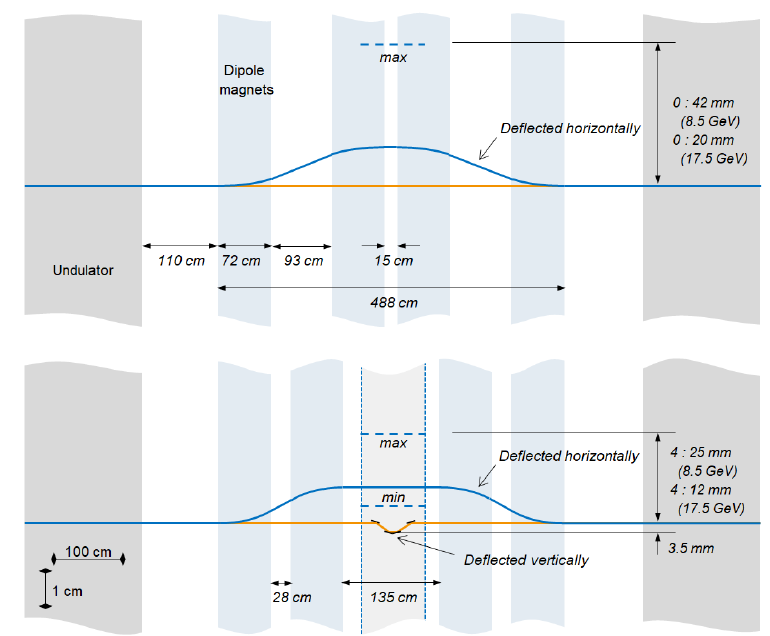
Figure A1. Concepts of chicane without (top picture) and with (bottom picture) optical delay line (ODL). Electron beam orbit is depicted with blue lines, radiation path with orange ones.